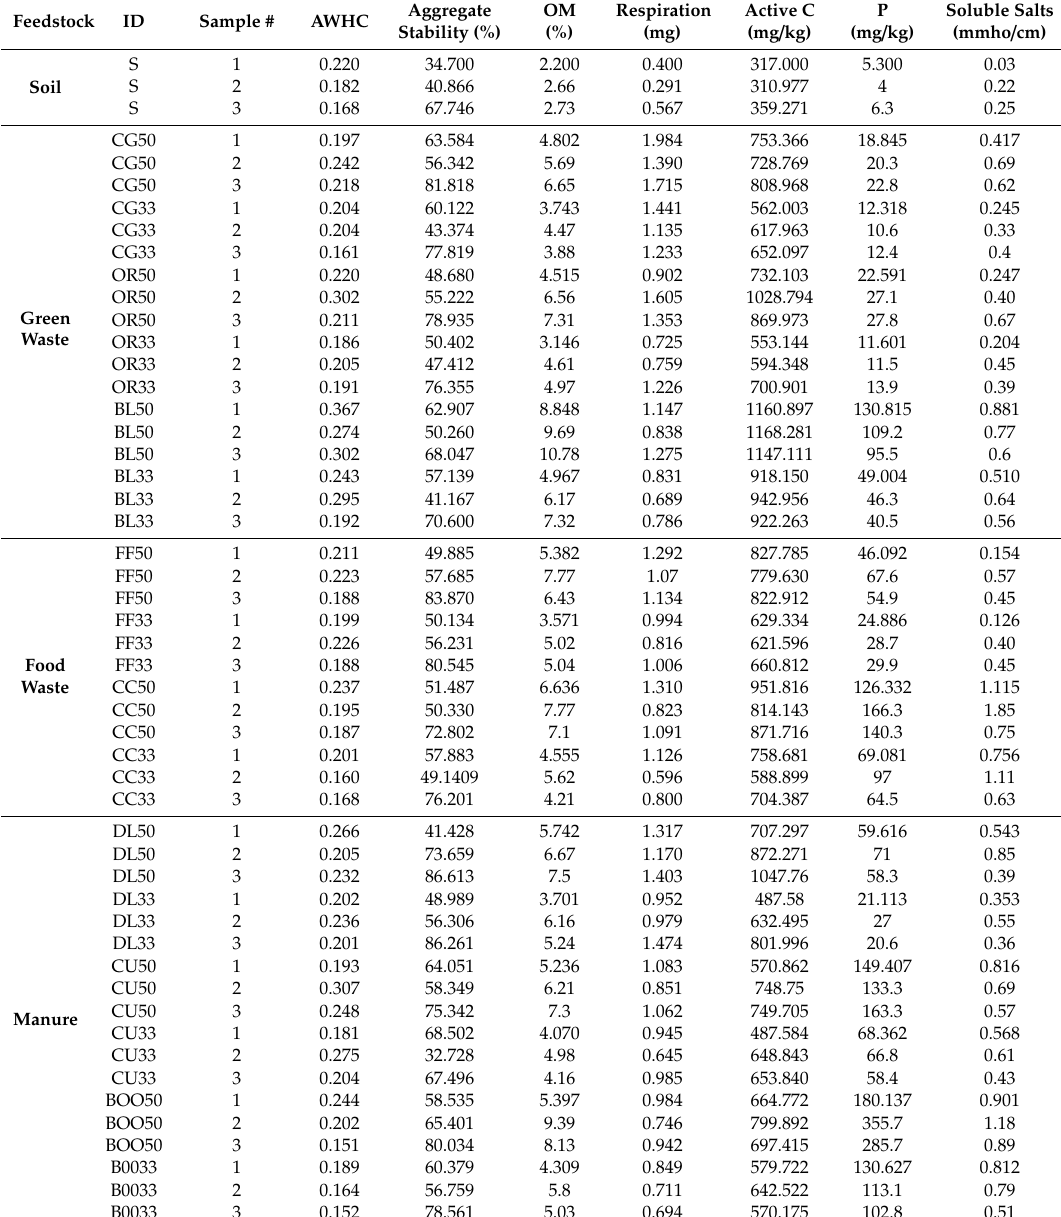
Table A1. Unamended and amended soil characteristics for all three samples taken during the